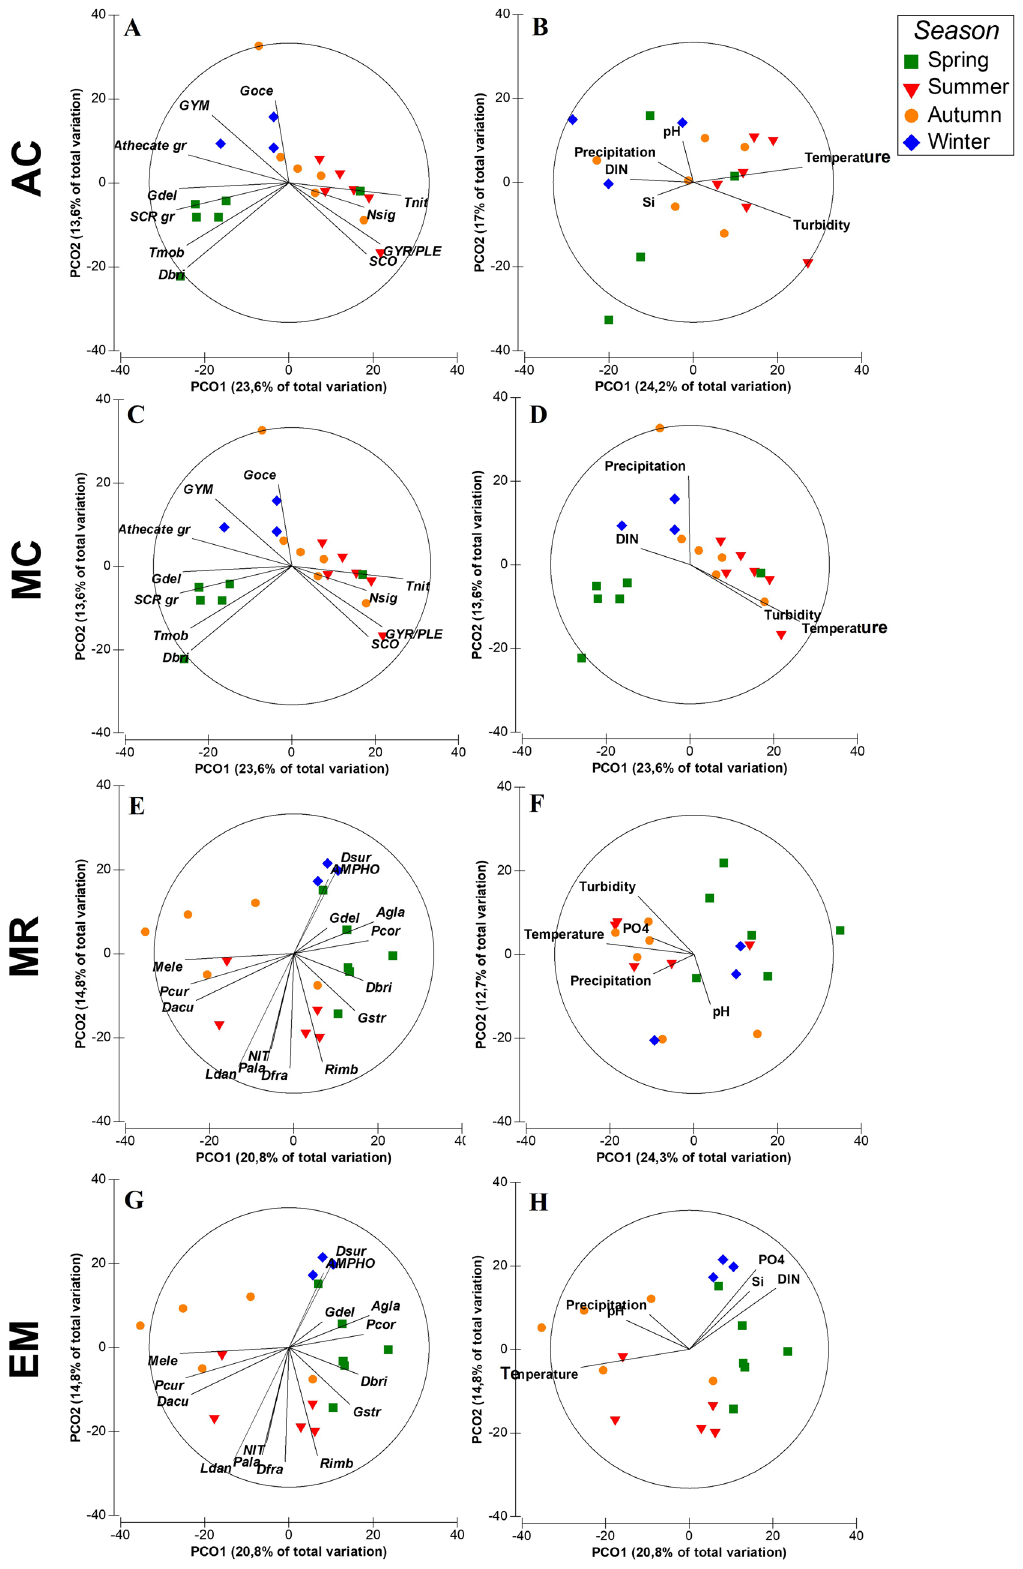
Figure 8. Principal coordinates analysis (PCO) plots of the abundance and composition of the phytoplankton community for each study site ( A / B —AC, C / D —MC, E / F —MR and G / H —EM). Represented as vectors overlapping the ordination are some of the taxonomic entities (abbreviated according to Table S2) with correlations above 0.5 (left panel), and the physico-chemical variables with correlations above 0.2 (right